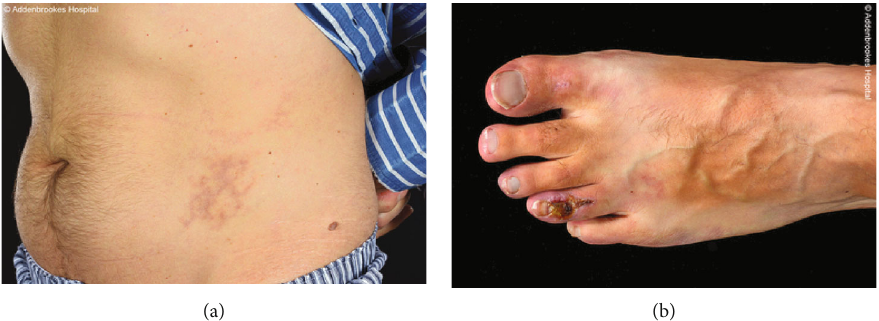
Figure 3: Case 2 — (a) Vasculitic skin rashes. (b) Nonhealing ulcers.